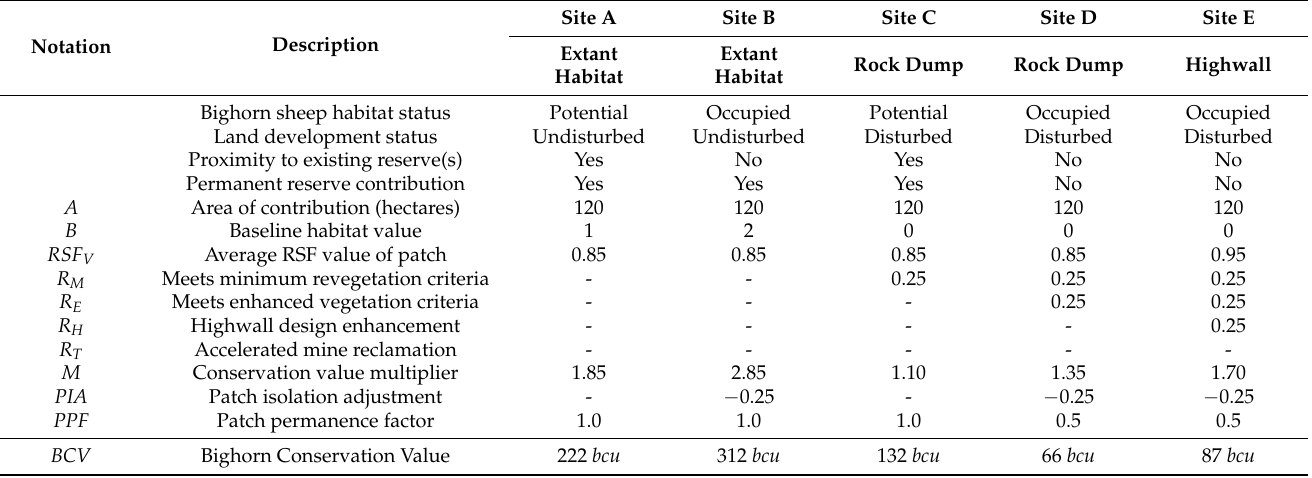
Table 1. Bighorn Conservation Value (BCV), expressed as bighorn conservation units ( bcu ), for five hypothetical mitigation sites on a landscape transformed by historic or ongoing mining activity. A reserve contribution formula * is applied to each site, which when aggregated, satisfies the total compensation requirement of 819 bcu